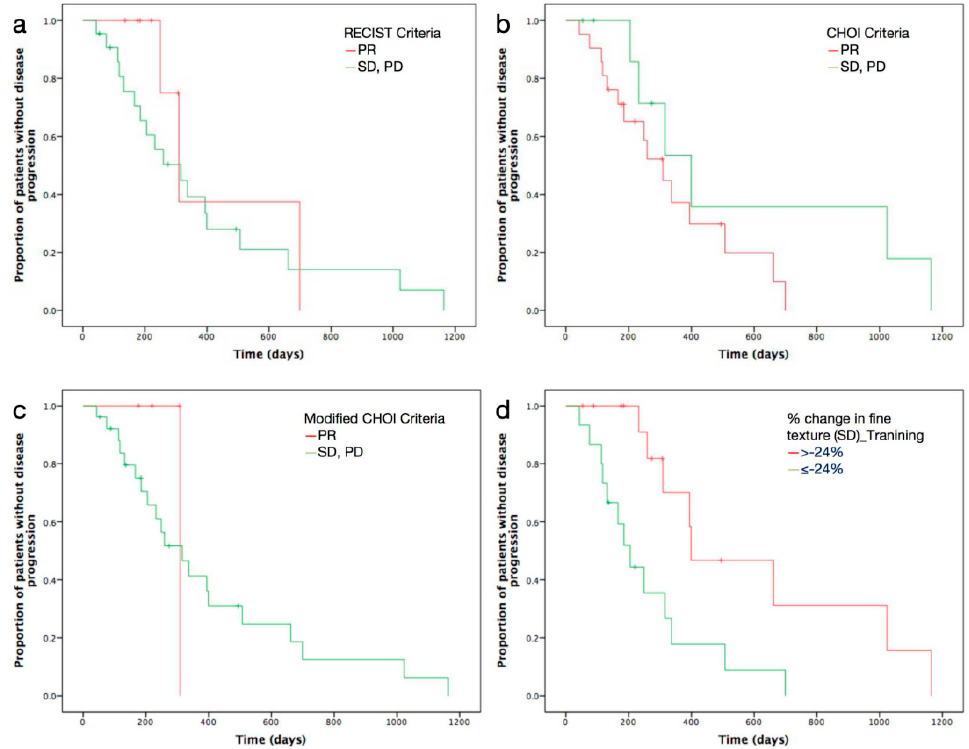
Figure 2. Kaplan-Meier curves show proportion of patients without disease progression for RECIST 1.1 ( a ), Choi ( b ), and modified Choi criteria ( c ) and percentage change in standard deviation (SD) ( d ). After the performance of multivariate Cox regression analysis, baseline MI at fine texture scale (SSF2, p value = 0.028), baseline kurtosis at medium texture scales (SSF3, p value = 0.032; SSF4, p value = 0.049), percentage change in kurtosis and SD at fine texture